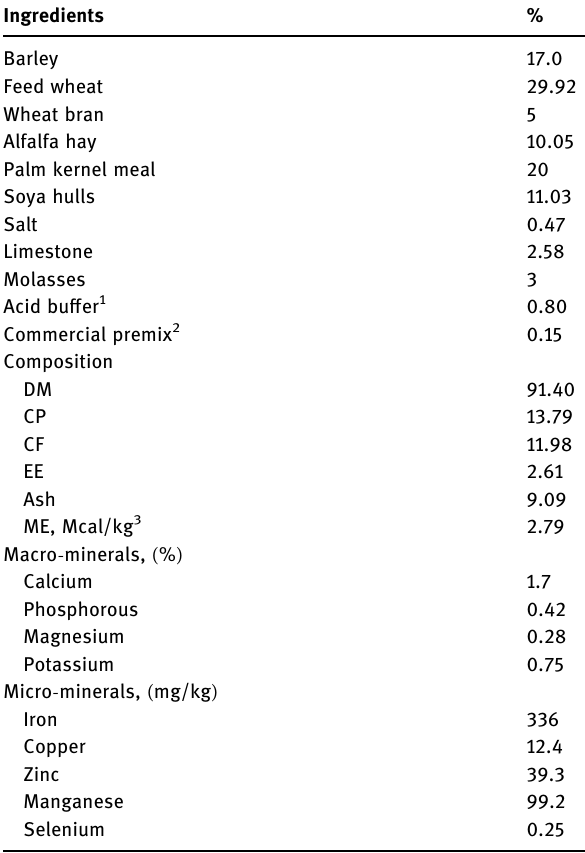
Table 1: Ingredients and chemical composition of the feeding trial diet ( Wa fi )